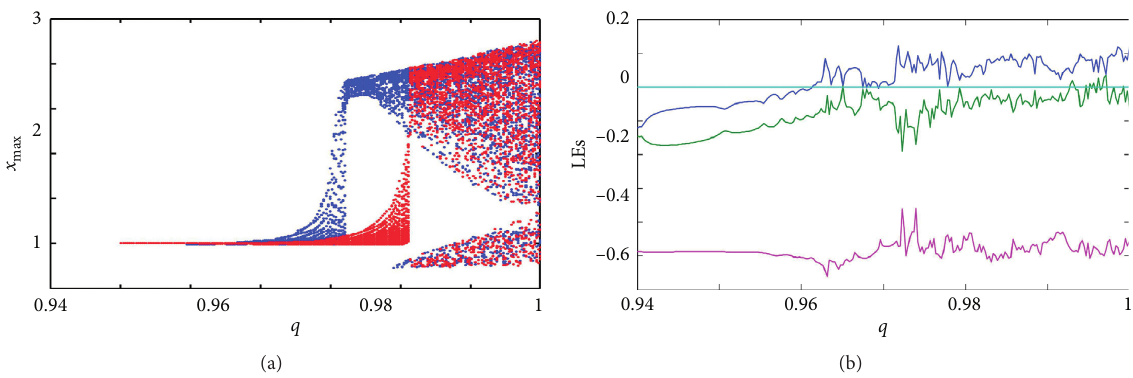
Figure 2: The dynamics of the fractional-order centrifugal flywheel governor system vary with derivative order q . (a) Bifurcation diagram. (b) Lyapunov exponent